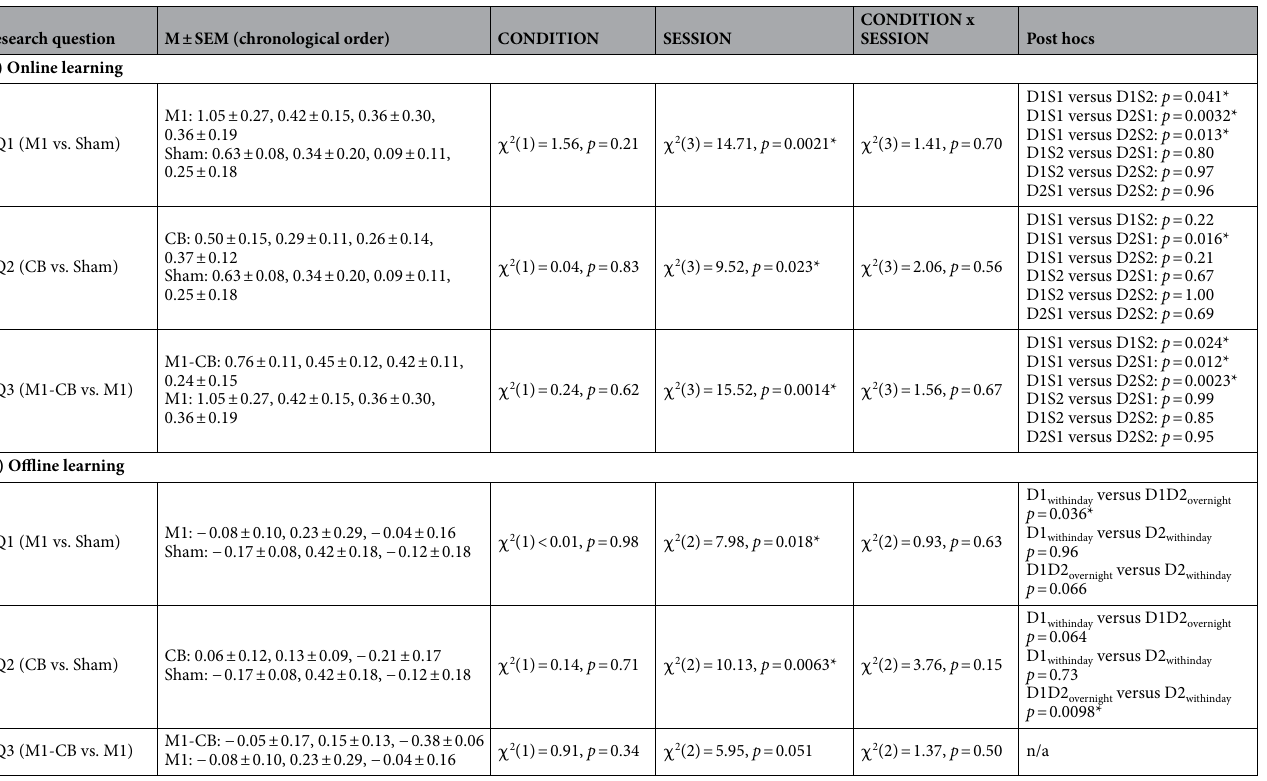
Table 1. Temporal components of learning. (a) Analysis of online learning, operationalised as difference between the last and the first block of a given session. (b) Analysis of offline learning defined as difference between the first block of the subsequent session and the last block of the preceding session. M1, monofocal M1 stimulation group; Sham, sham group; CB, monofocal cerebellar stimulation group; M1-CB, multifocal motorcortical-cerebellar stimulation group; M, mean; SEM, standard error of the mean. * depicts p < 0.05.